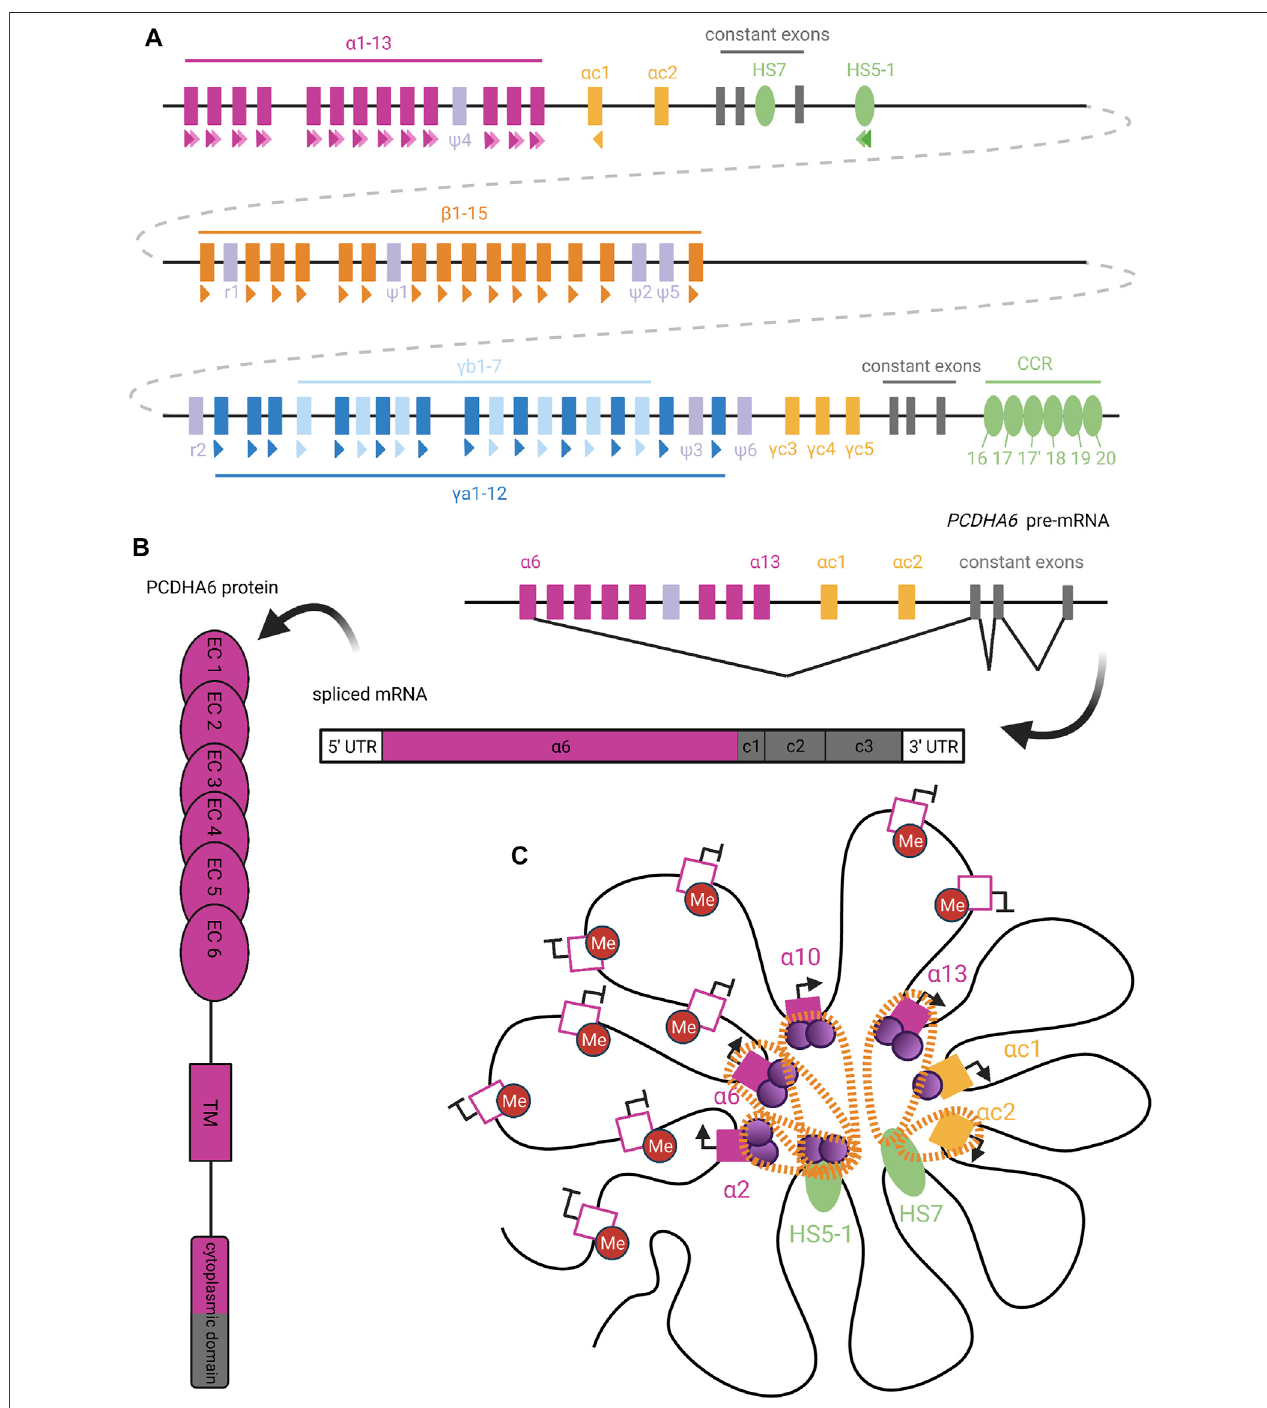
FIGURE 6 | Organization and Expression of Protocadherins. (A) Genomic organization of the human clustered protocadherins. In humans, the PCDHA , PCDHB , and PCDHG genes are arranged in tandem clusters, with a few intervening pseudogenes (lavender), in the 5q31 region of chromosome 5 (Wu and Maniatis, 1999). The PCDHA and PCDHG clusters also have deterministically-expressed terminal V exons (yellow) and constant exons (grey), while the PCDHB cluster only contains stochastically-expressedVexons(Tasicetal.,2002).Coloredtriangles underexonsorenhancers denoteCSEs, withstaggeredtrianglesindicatingtwoCSEsfora given element. (B) Upon PCDHA promoter selection, transcription proceeds through all downstream V and C exons. Intervening V exons are spliced out such that mature PCDHA mRNA contains just one variable exon spliced to three constant exons (Tasic et al., 2002). The variable exon encodes six ectodomains, the transmembranedomain,andtheN-terminalhalfofthecytoplasmicdomaininthePCDHAprotein;therestisencodedbytheconstantexons(MahandWeiner,2016). (C)